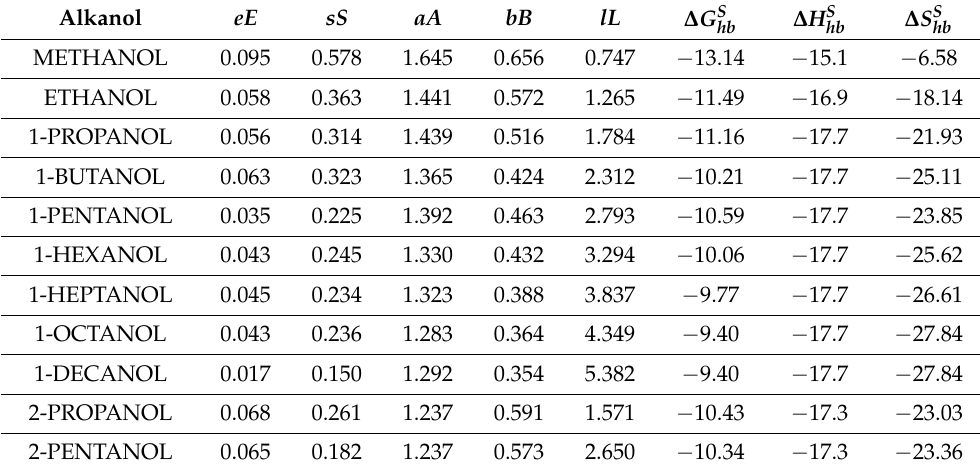
Table 1. The five contributions (cf. Equation (2)) to the equilibrium constant ( − logK S ) for the self- solvation free energy of alkanols [16,60]: the hydrogen bonding contribution, ∆ G S free energy (in kJ/mol); the experimental [61] hydrogen bonding contribution, ∆ H S solvation enthalpy (in kJ/mol); and the calculated hydrogen bonding contribution to the self-solvation entropy (in J/mol K) of alkanols. Alkanol eE sS aA bB lL ∆ G S